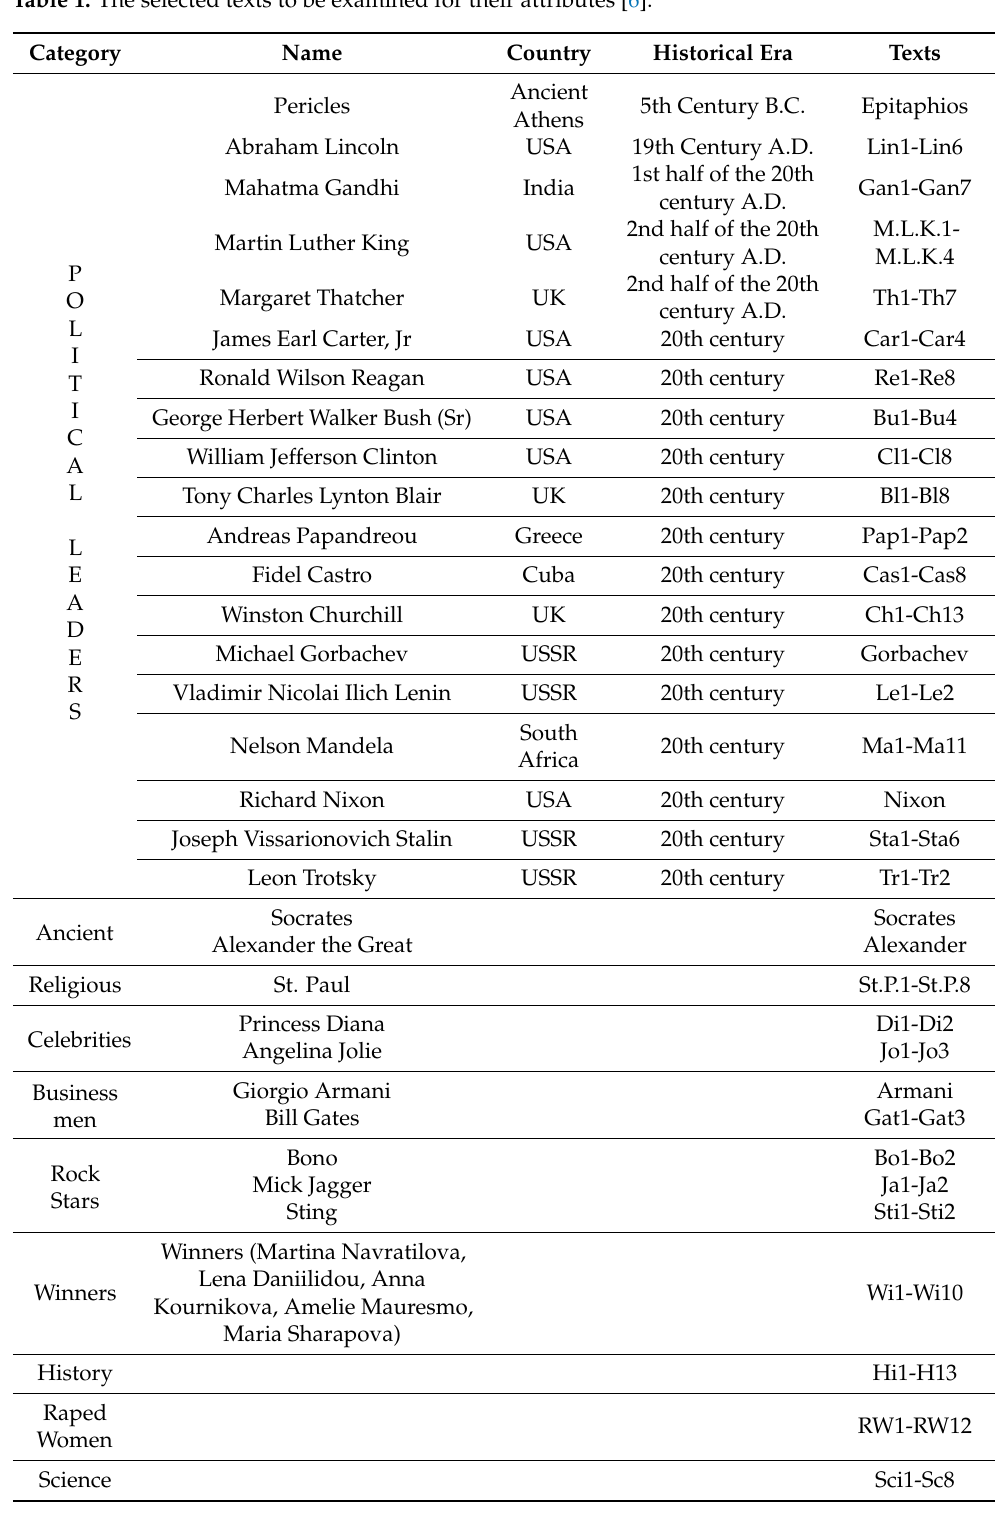
Table 1. The selected texts to be examined for their attributes [6].